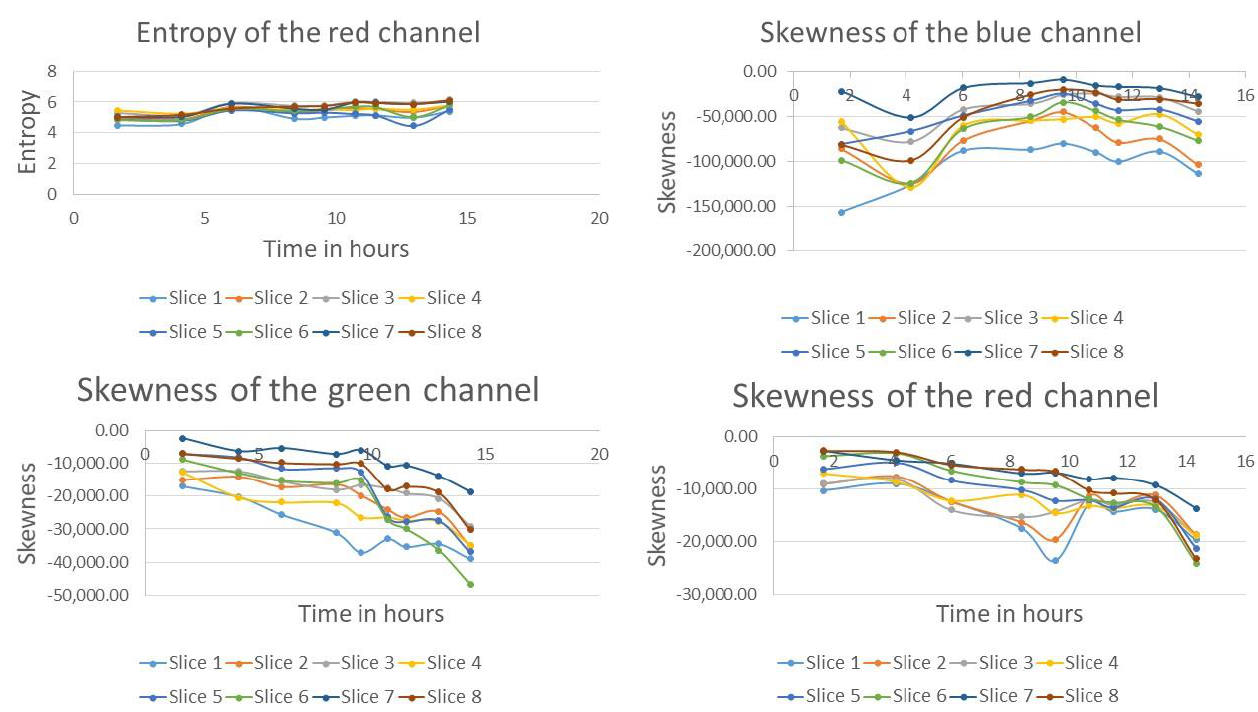
Figure 9. Drying curves for other visual features.